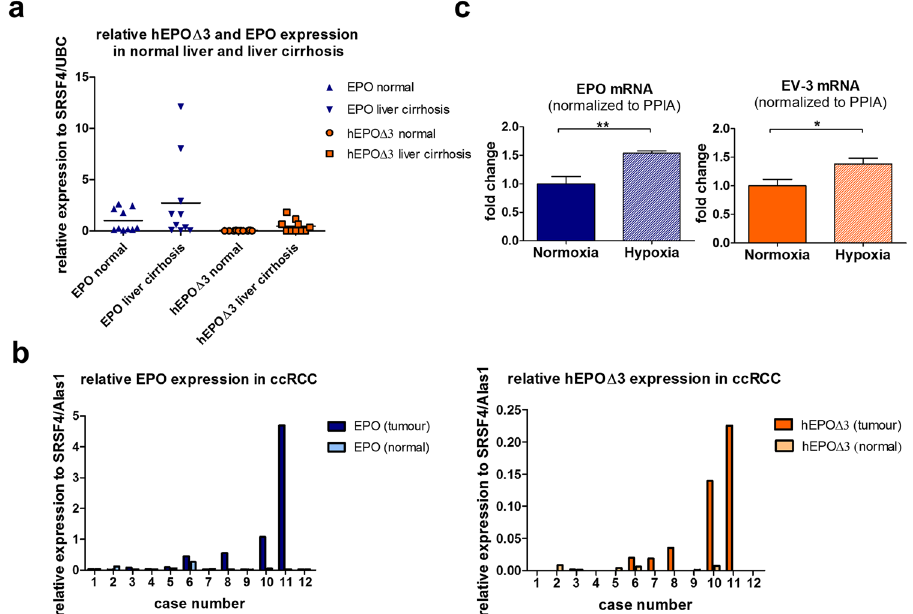
Figure 2. Expression analysis of EPO and hEPO Δ 3 transcripts in human tissues and the human cell line HepG2 using quantitative PCR. ( a ) Normal and cirrhotic liver FFPE samples (n = 10 per condition) were analysed, using UBC and SRSF4 as reference genes. EPO mRNA expression is detectable in both normal ( ▲ ) and cirrhotic liver tissue ( ▼ ), individual cirrhotic samples show 3–6 fold increase compared to mean of normal tissue. hEPO Δ 3 is only amplified from cirrhotic livers ( □ ) but not from normal livers ( ○ ). ( b ) EPO and hEPO Δ 3 expression was analysed in clear cell renal cell carcinoma FFPE samples and compared to adjacent normal tissue (n = 12 per condition). Expression levels of SRSF4 and Alas1 were constant in tumour and matched normal tissue and served as reference genes. EPO expression is enhanced in clear cell renal cell carcinoma samples 8, 10 and 11 compared to adjacent normal tissue. These samples show also highest hEPO Δ 3 expression. ( c ) EPO and hEPO Δ 3 expression is induced in HepG2 cells exposed to hypoxic conditions (1% O 2 ) for 4 h. Cyclophilin A expression was not affected by hypoxia and used as internal control gene. (n = 4); two-tailed t-test; mean ± SEM